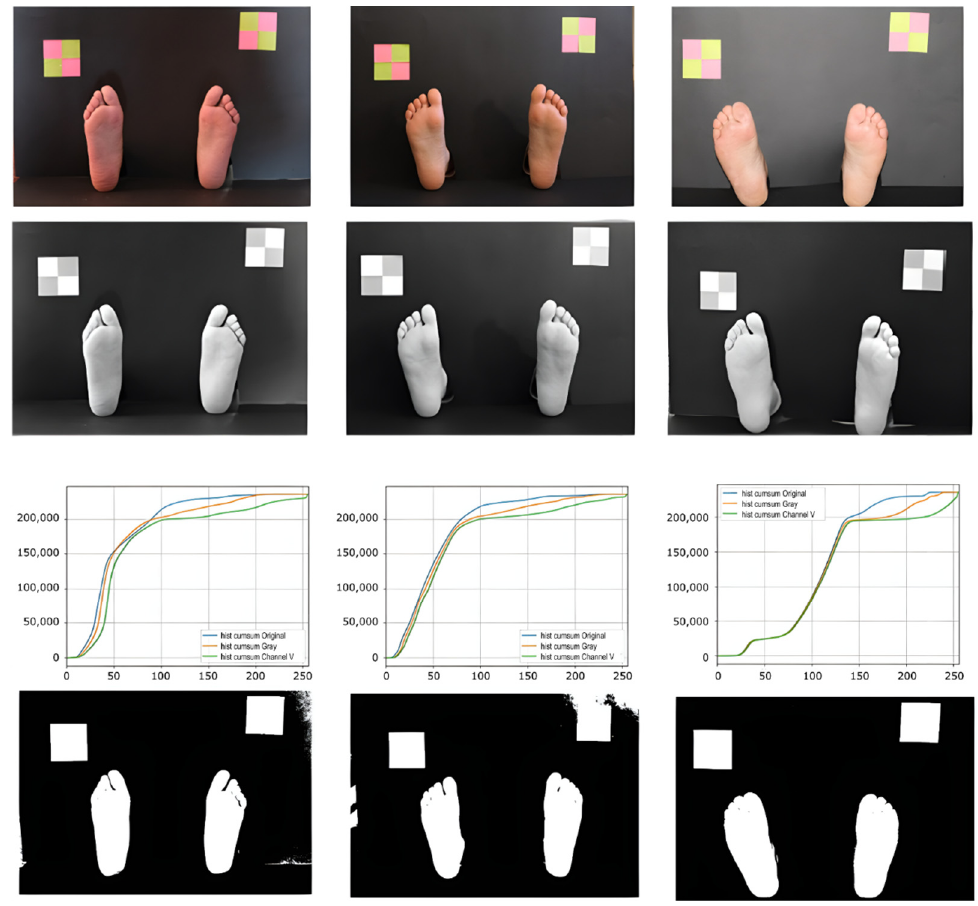
Figure 4. Picture examples along the background segmentation pipeline. First row shows the original images; second row shows the V channel in HSV color space; third row shows the accumulated histograms for the original image (blue), grayscale image (orange), and V channel (green); forth row shows the binarized images.